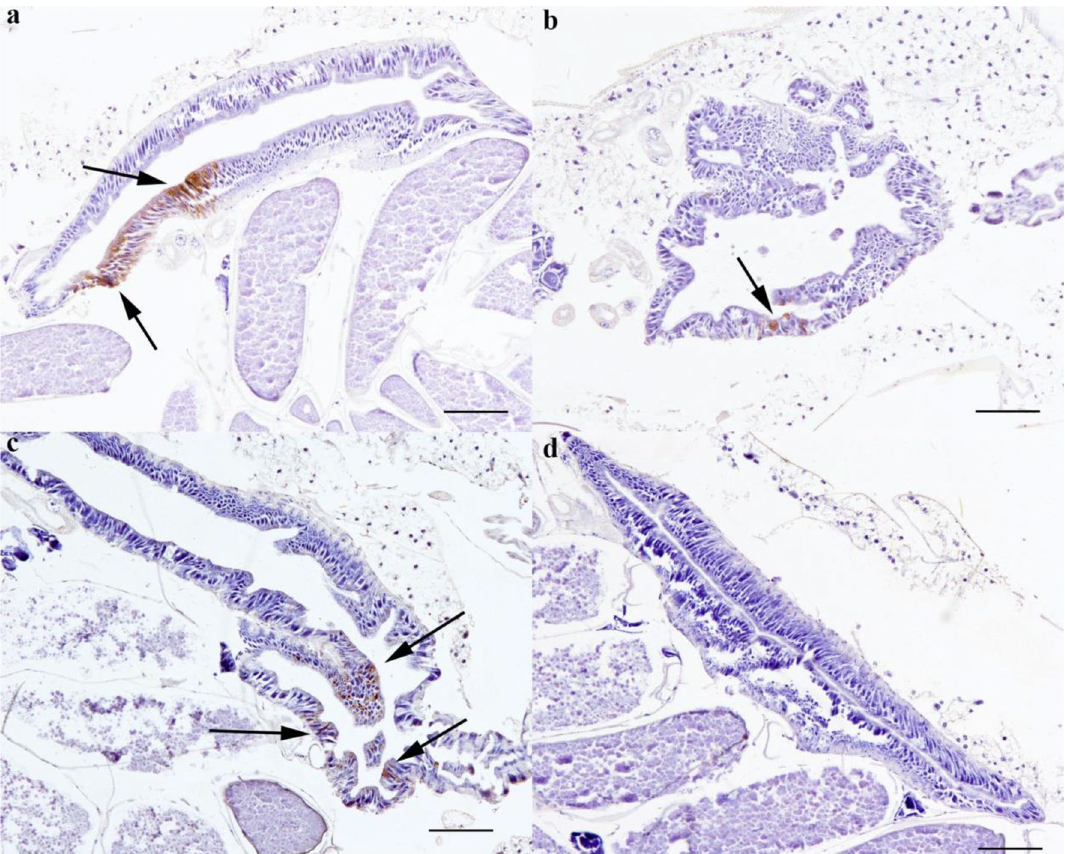
Figure 4. Variability of midgut infection by JEV in C. pipiens. Positive immunolabeling observed in posterior midgut of infected blood-fed mosquitoes ( a – c ) and unsuccessful infection ( d ). There is variability in the number of positive immunostained cells. Some mosquitoes showed high numbers of immunolabeled cells ( a ), singly immunostained epithelial cells ( b , c ) and no positive labelling ( d ). Scale bar: 100 in South East Asia and Australia it is likely that vectors have variable competence for virus transmission and that this is likely influenced by viral genotype, temperature and extrinsic incubation period. JEV is endemic throughout South East Asia with repeated incursions into north east continental Australia 8,46 . These areas are typified by a tropical, humid climate with consistently high temperatures unlike temperate regions. However, climatic changes in temperate zones have resulted in longer warmer summers 12 . Therefore, the likelihood of extended time periods at temperatures that fall between our treatments occurring during the summer months in temperate regions is becoming increasingly feasible. In addition, these conditions enable mosquitoes, and arthropods in general, to remain active for a longer period of the year, increasing the likeli- hood of transmission events and impacting disease epidemiology more generally 22 . We would note that our experimental temperature conditions maintained constant heat and humidity with a 24-h day night photoperiod (12:12), which is typical of vector competence studies 25,28,47 . However, these conditions are not representative